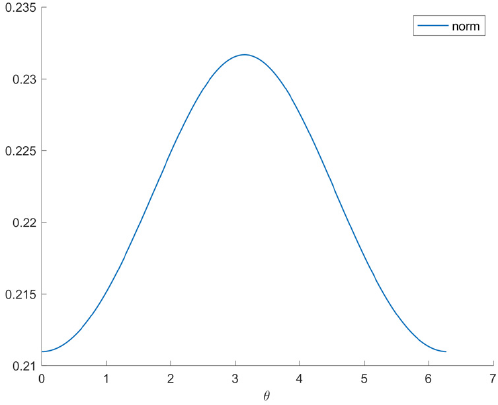
Figure 15. Value of sup